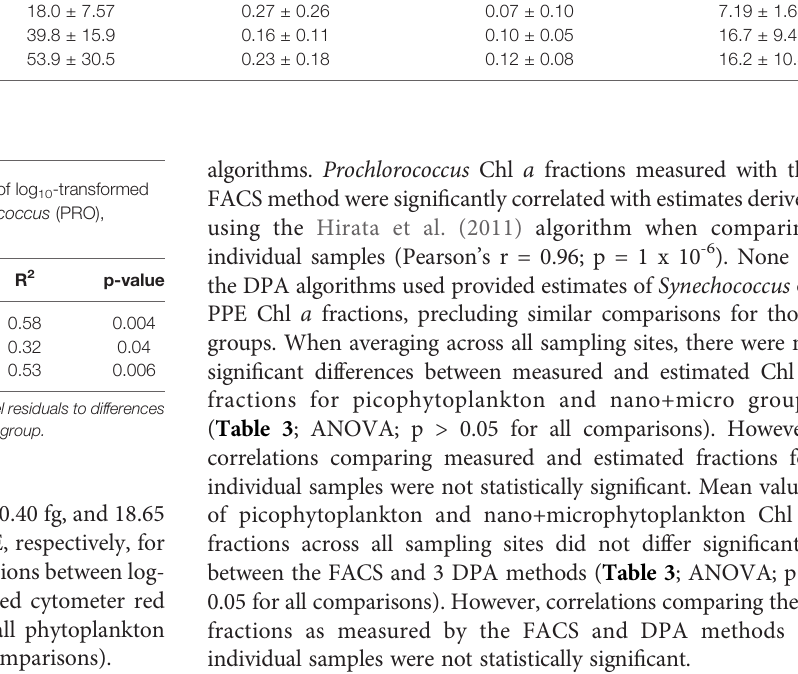
Error values correspond to the standard deviation of the mean.